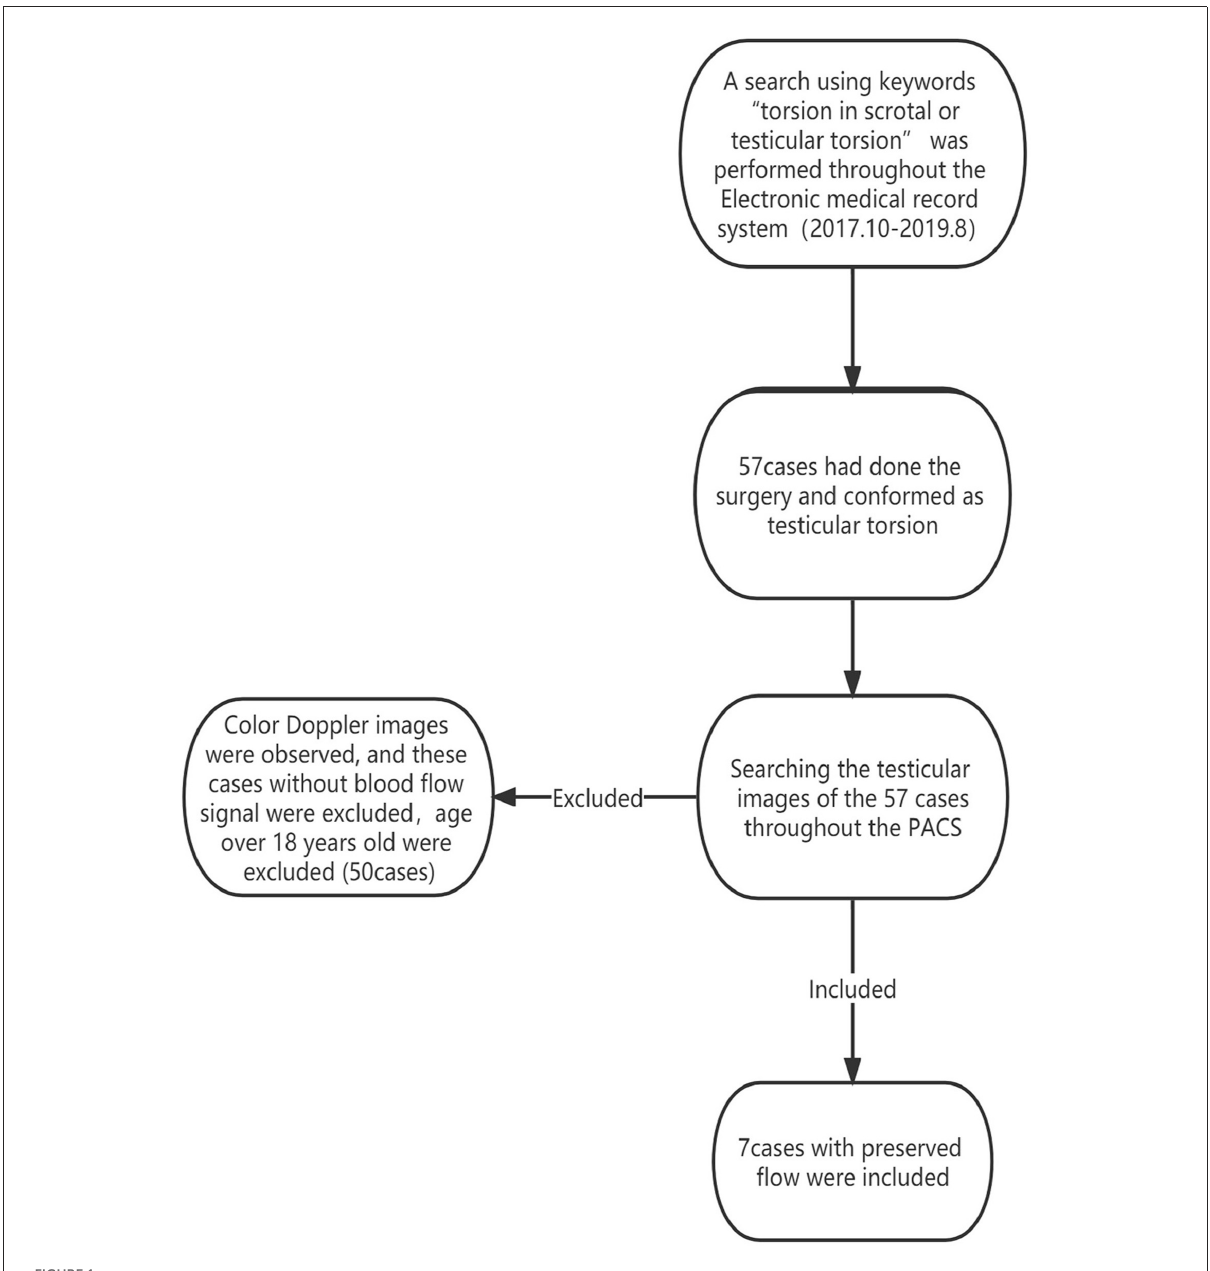
FIGURE1 A flowchart of